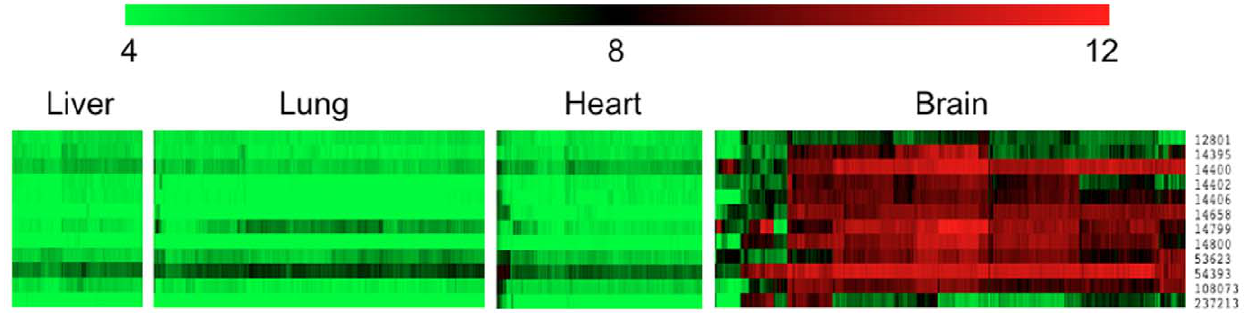
Figure 8. Heatmaps of log 2 expression values of the twelve candidate genes from Table 8, in various tissues. Green is low, black is middle and red is high expression. doi:10.1371/journal.pone.0009056.g008 PLoS ONE |